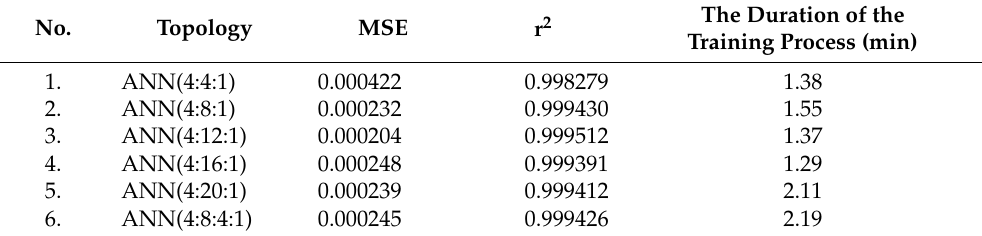
Table 5. The structure of neural models and the performances obtained in the training stage.